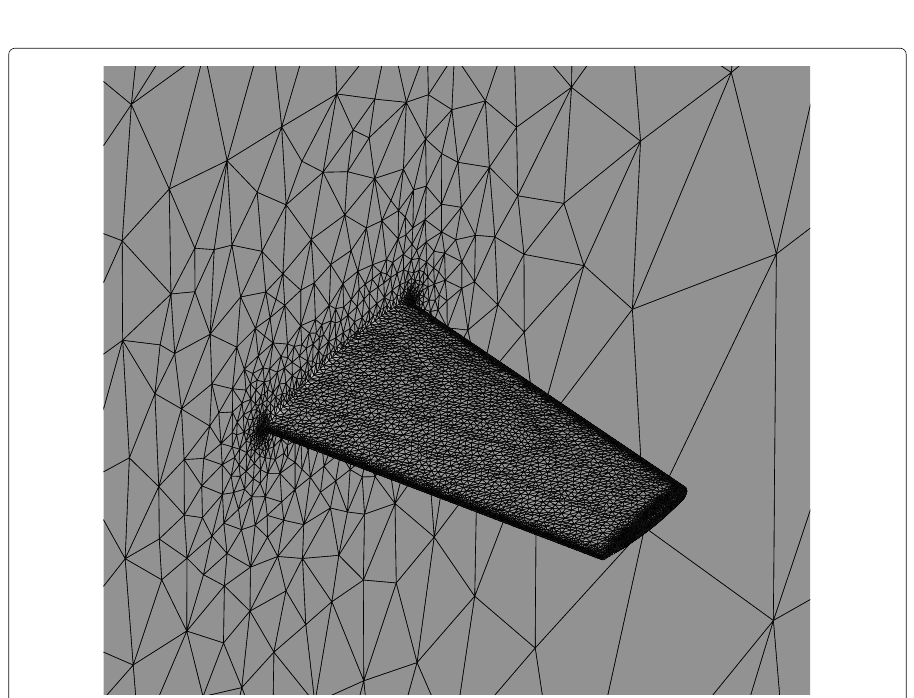
Fig. 9 Pressure coefficient distributions on the surface of the NACA0012 airfoil